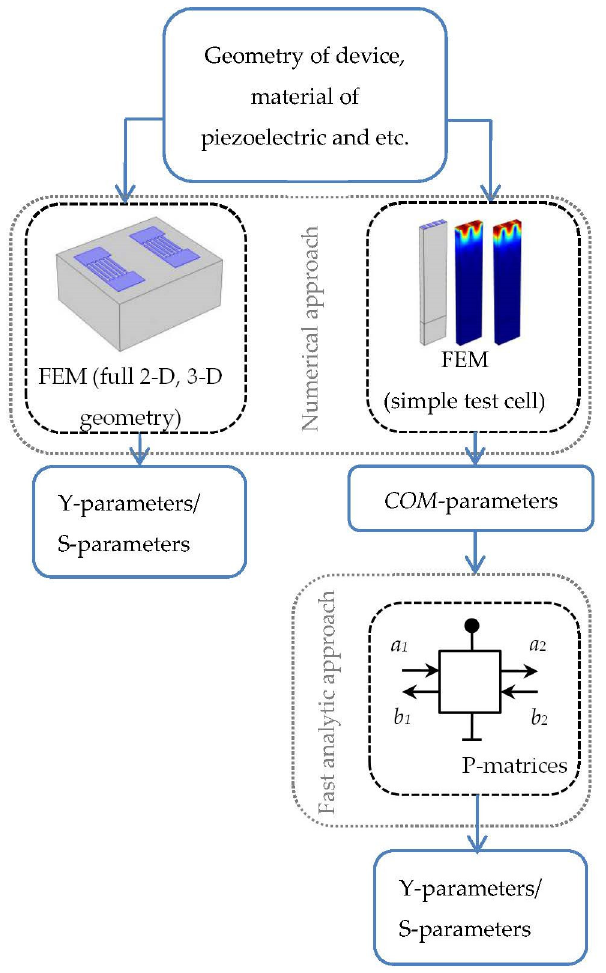
Figure 2. The modern approaches for calculating the frequency responses of SAW devices.